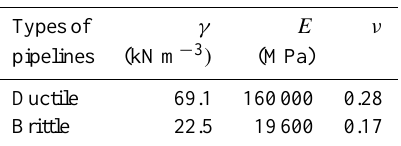
Table 5. Mechanical characteristics of pipelines used in numerical analysis.